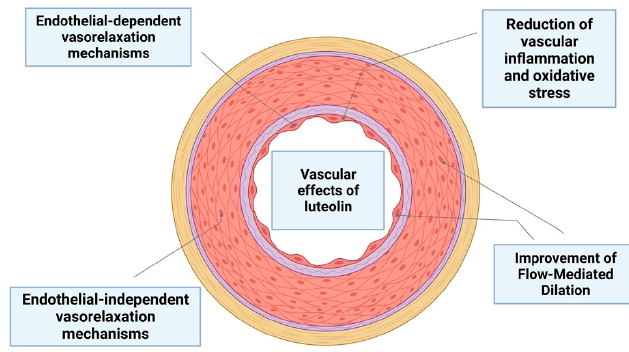
Figure 7. Luteolin and LUT-7 effects on vascular